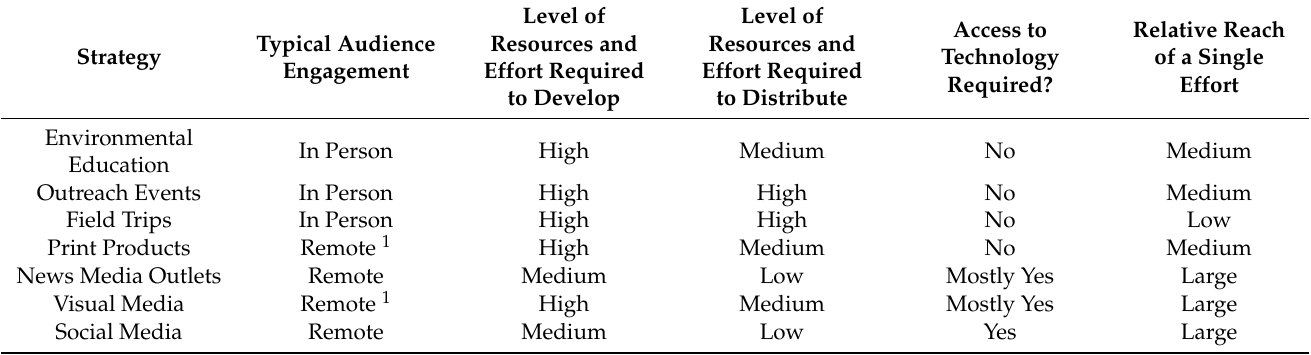
Table 1. Comparison of attributes of conservation communication tools. Low reach is considered dozens to hundreds of people, medium reach is hundreds to thousands of people, and large reach is thousands to hundreds of thousands of people.